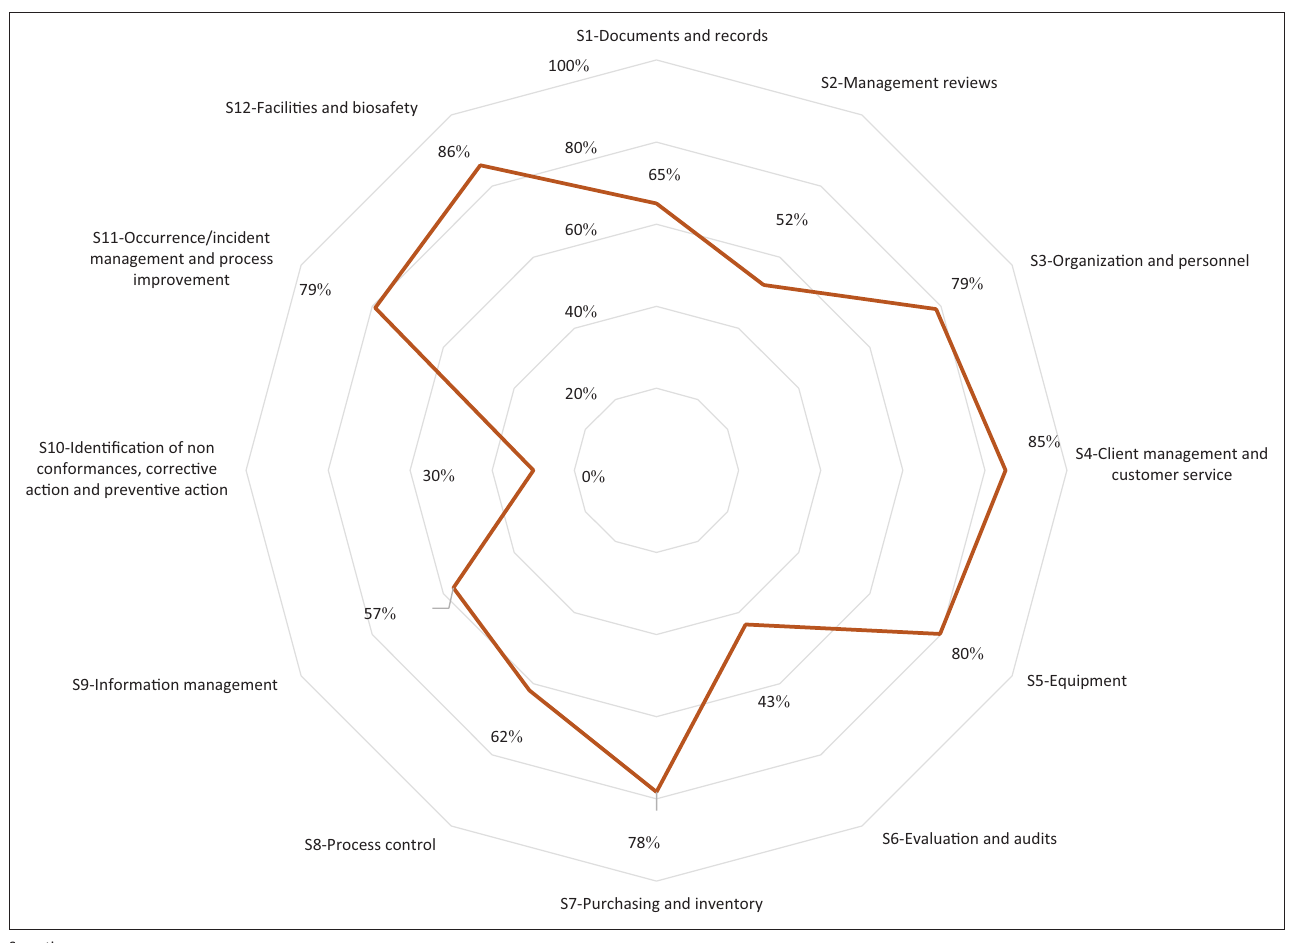
S, section. FIGURE 3: Spider chart showing mean scores for 10 University of Maryland, Baltimore-supported laboratories for Stepwise Laboratory Quality Improvement Process Towards Accreditation sections audited in September 2017,